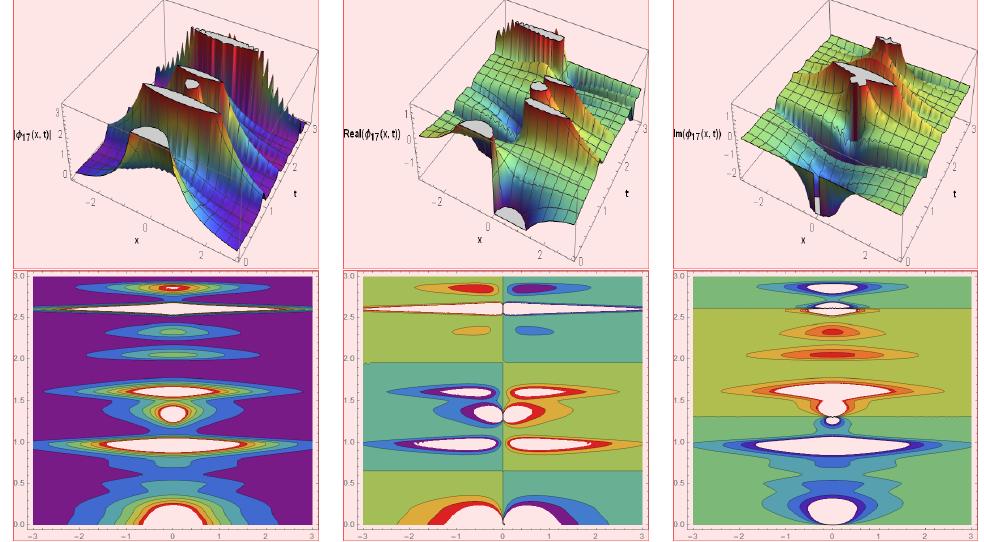
Figure 9. The absolute, real, and imaginary behavior in the shape of 3D and their corresponding contour plots are dispatched for ψ 17 ( x , t ) .